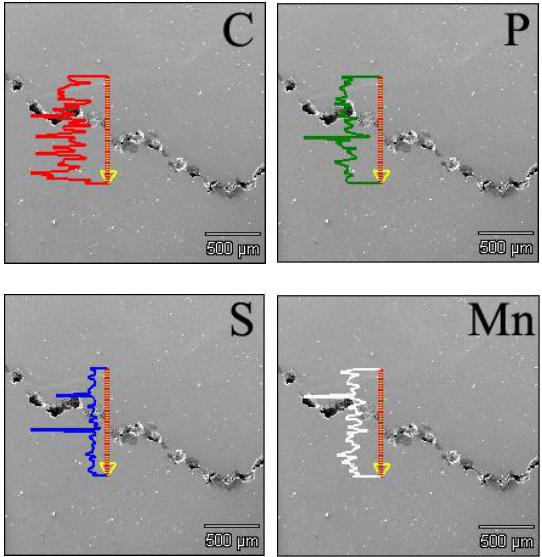
Figure 4. Line scanning of SEM in the crack